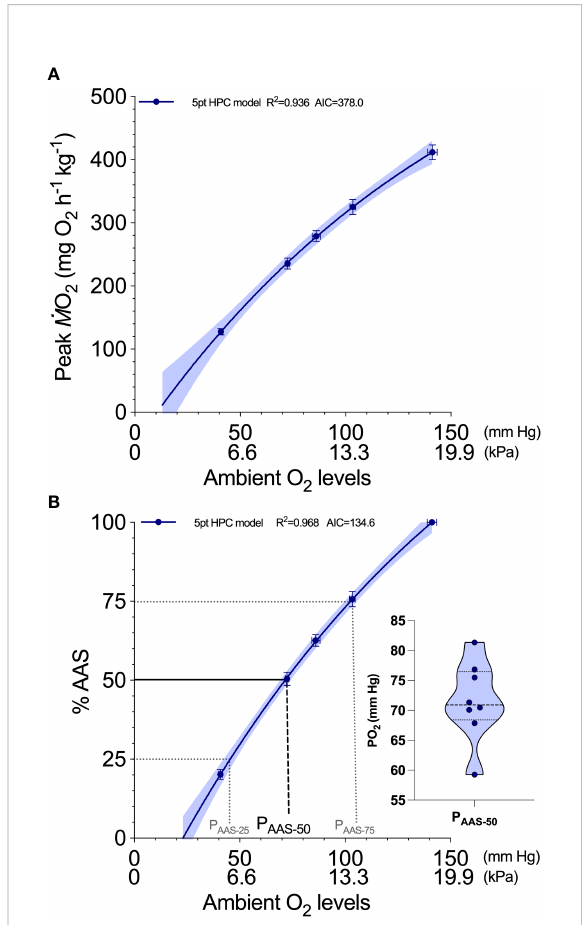
FIGURE 3 A hypoxia performance curve (HPC) characterizes the quantitative ( M O ˙ 2peak ) when the constraint on whole-organism peak M O ˙ 2 _ MO 2 ð _ MO 2 peak Þ ambient oxygen (O 2 ) level (partial pressure of oxygen: % sat. or kPa) is progressively reduced (adapted from Zhang et al., 2022). (A) In this example for a group of eight individually tested rainbow trout ( Oncorhynchus mykiss ) at 11°C, their individual hypoxia performance curves are pooled as mean (and SEM), where data are plotted at fi ve strategically selected ambient O 2 levels that bracket a 50% reduction and are above the critical oxygen tension (P crit ), when absolute aerobic scope (AAS) is zero. These data points are then reliably modeled (a hyperbolic curve in this case: R 2 = 0.936, AIC = 378.0) to generate the HPC (solid blue line) and its 95% CI ) data can be normalized to an (blue shade). (B) These ( M O ˙ 2peak _ MO 2 peak absolute aerobic scope (AAS) of each individual and reliably modeled (a hyperbolic curve in this case: R 2 = 0.968, AIC = 134.6) to generate the HPC (solid blue line). Extrapolation of this model , curve should approximate P crit and the normoxic maximum M O ˙ 2 _ MO 2 both of which can be tested independently for veri fi cation purposes. Most important is that this curve, which accounts for ), can be interrogated through individual variation in ( M O ˙ 2peak _ MO 2 peak interpolations. For example, the minimum oxygen tension to support a portion of AAS (e.g., 75%, 50%, and 25%) can be quanti fi ed as standardized comparative metrics. We recommend the P AAS-50 (minimum PO 2 that supports 50% of AAS) which are shown as individual data in the insert (violin plot: dash line = median, dotted line =